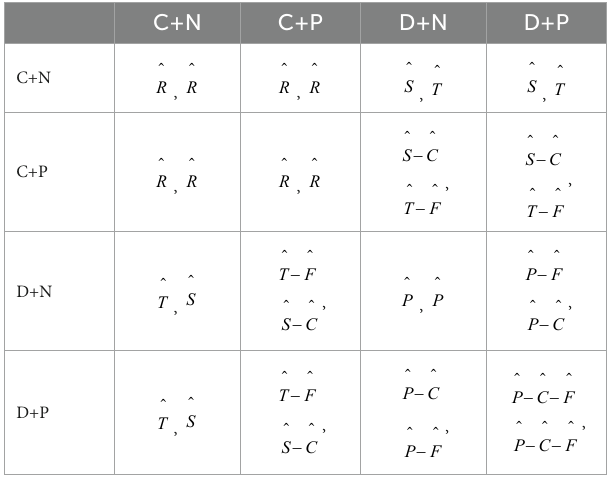
(Table 6), where β 2 and α 2 represent the parameters of peripheral subjects.